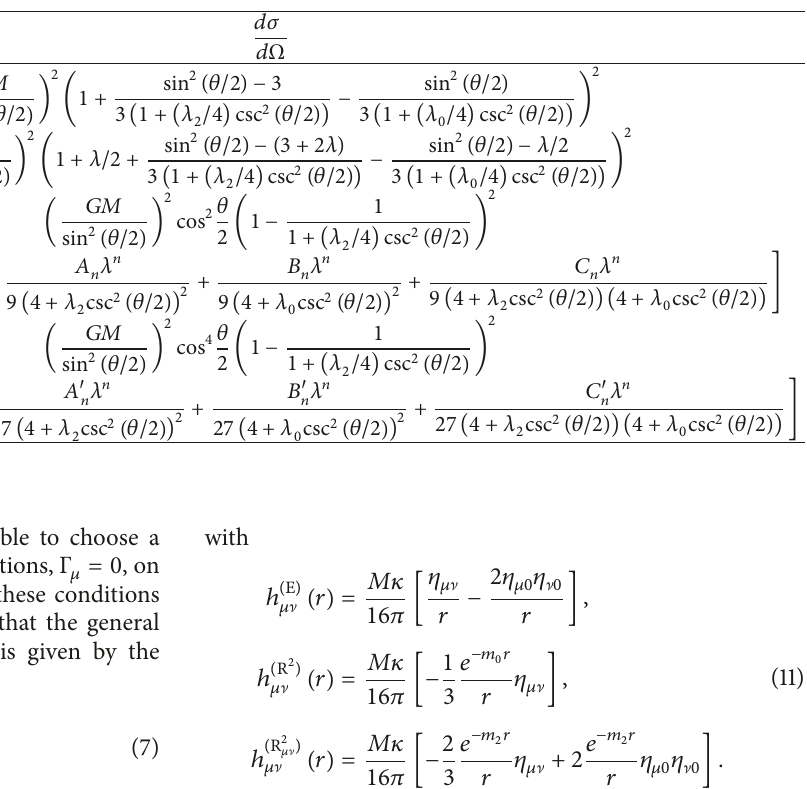
Table 1: Unpolarized differential cross sections for the tree-level scattering of different quantum particles by an external weak higher-order gravitational field, where 𝜃 is the scattering